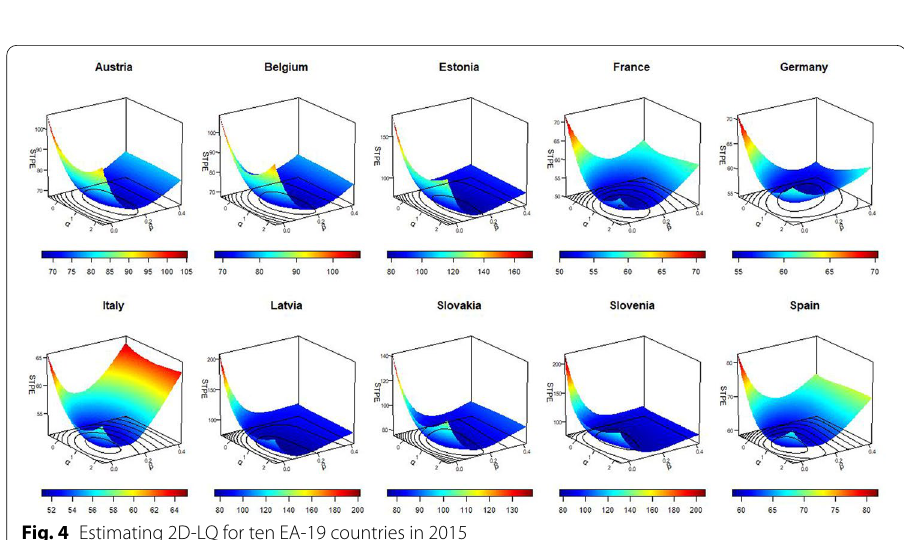
lines are also highlighted with a fixed gradation by country and year. The optimal pair of